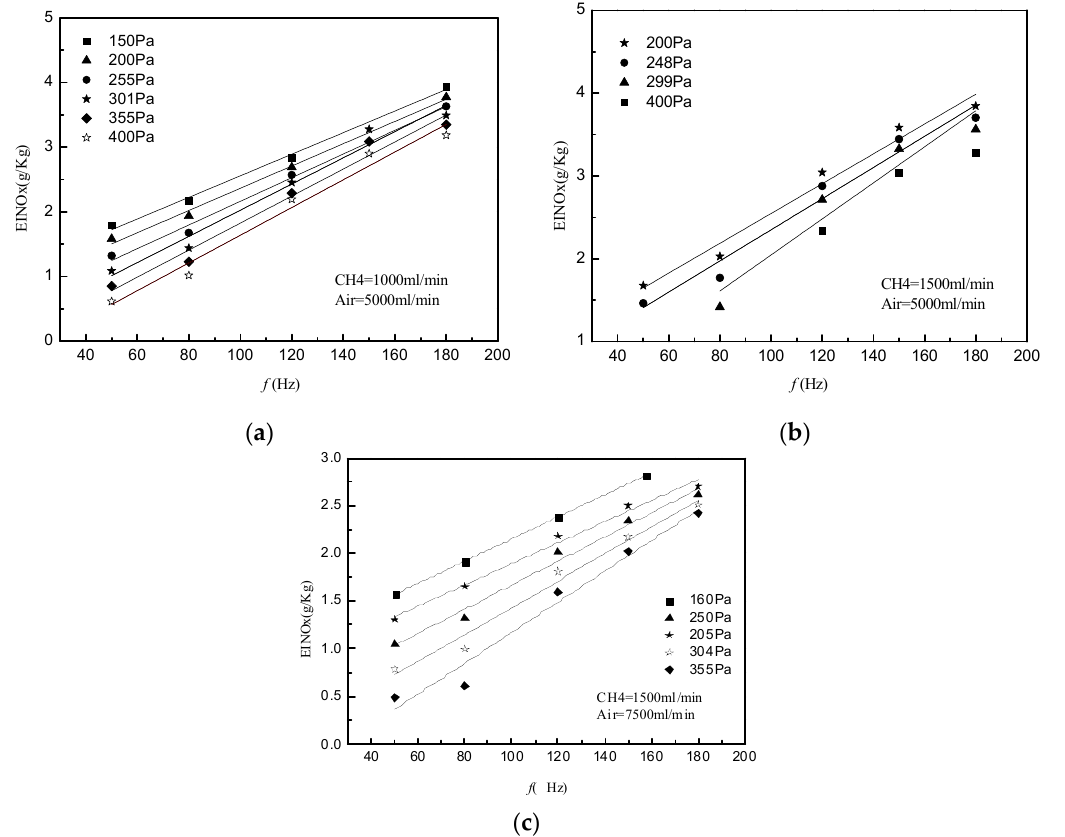
Figure 5. NOx emission characteristics with acoustic amplitudes (0–180 Hz) ( a ): Case 1; ( b ): Case 2; ( c ): Case 3